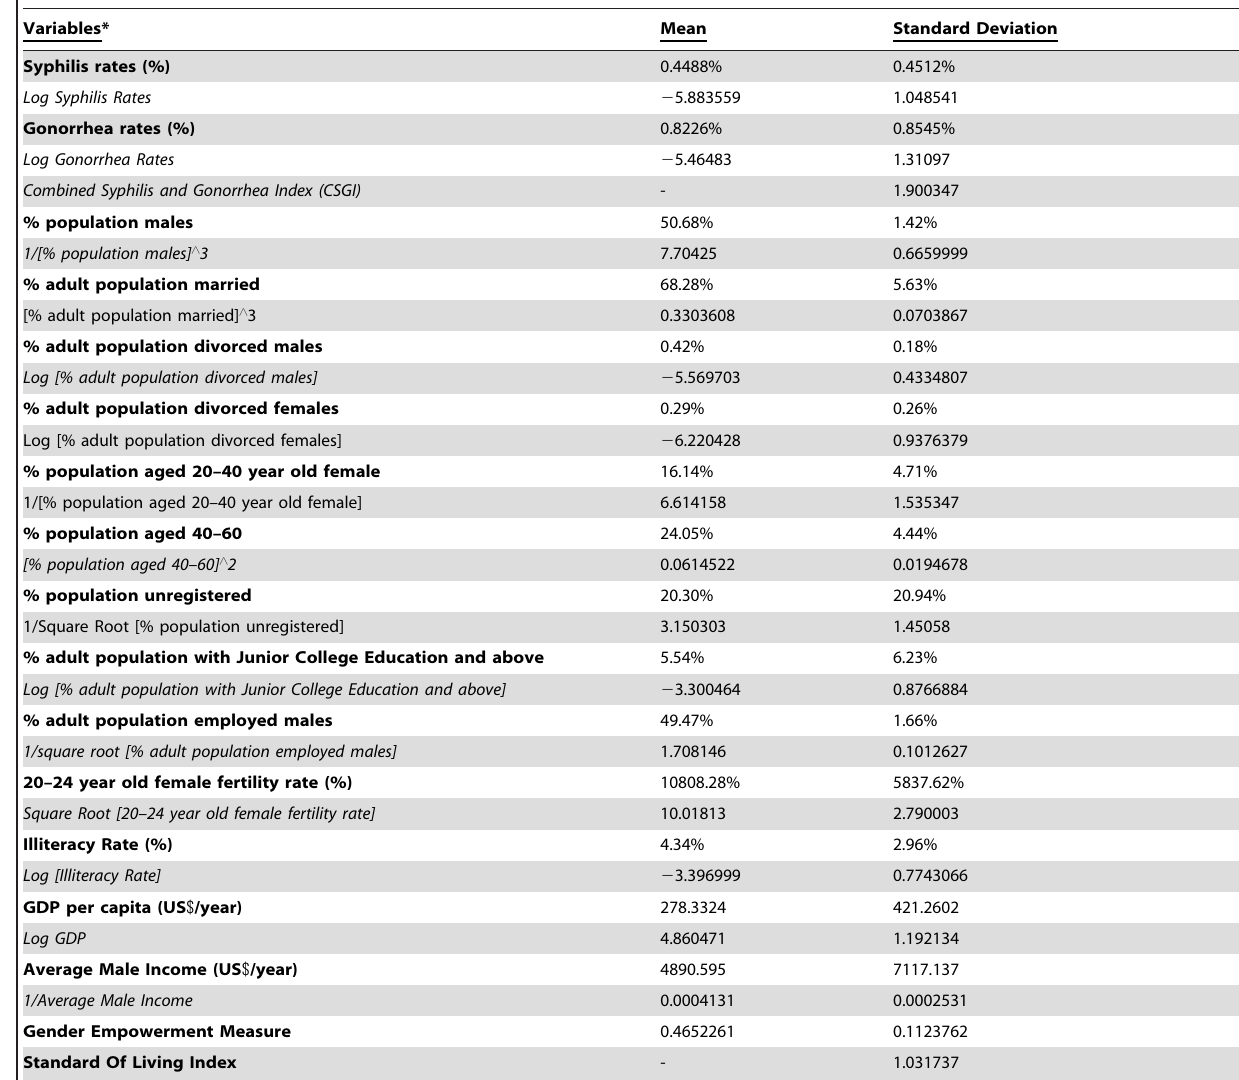
Table 1. Independent and Dependent